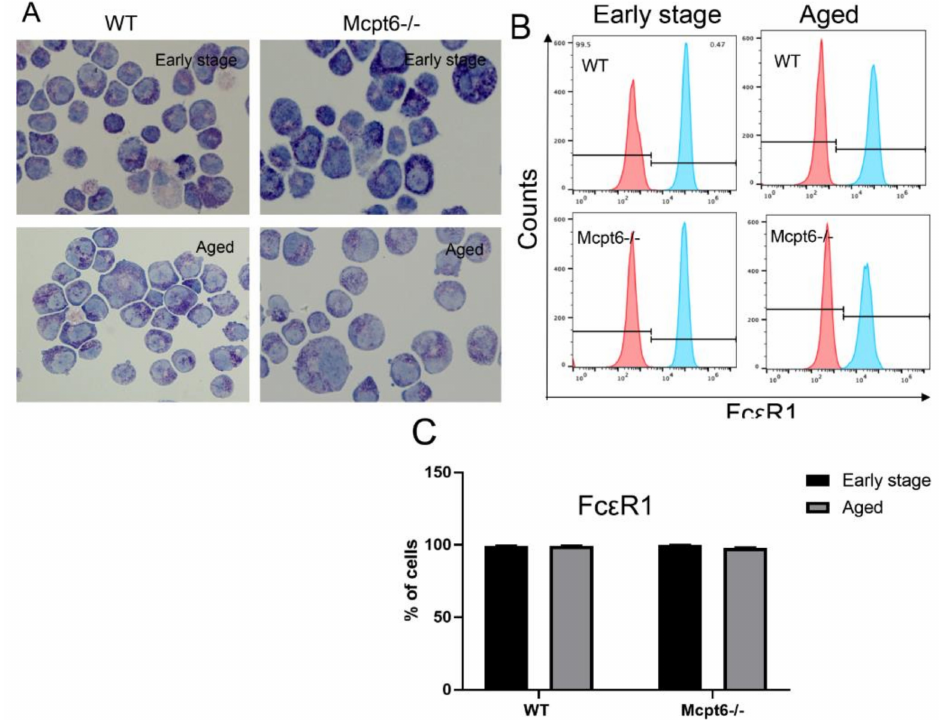
Figure 1. Early stage and aged wild-type (WT) and tryptase-deficient (Mcpt6 − / − ) mast cells (MCs) have similar morphology and express the high a ffi nity IgE receptor. ( A ) Early stage (~8 weeks) and aged ( > 50 weeks) WT and Mcpt6 − / − bone marrow-derived MCs were stained with May-Grünwald / Giemsa. Images representative of three independent cultures are shown. Note that WT and Mcpt6 − / − MCs display similar content of May-Grünwald / Giemsa-positive granules ( B ) Histogram showing Fc ε R1 staining of early stage and aged WT and Mcpt6 − / − MCs, analyzed by flow cytometry. ( C ) Quantification of Fc ε R1 + cells ( n = 3; representative of three independent experiments), showing that WT and Mcpt6 − / − MCs express equal levels of Fc ε R1. Data are presented as mean values ± SEM and Sidaks multiple comparison test or by Two-way